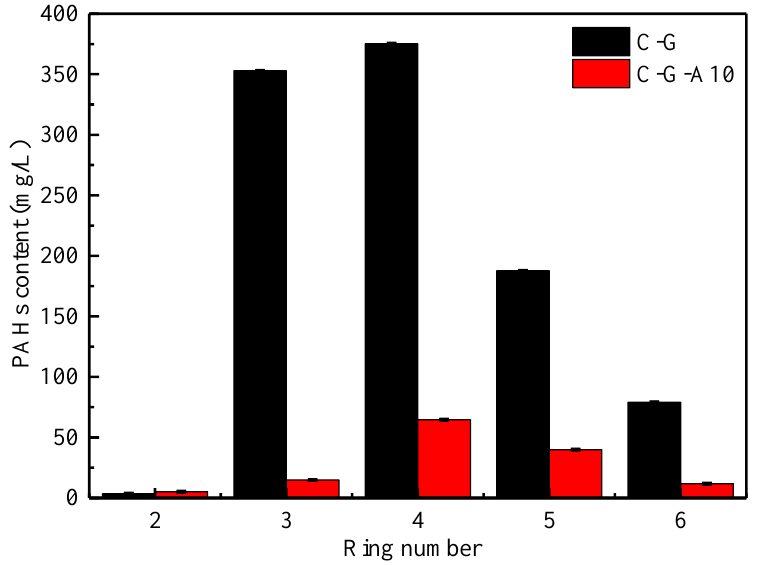
Figure 8. Content of different ring number PAHs in flue gas of coal and pitch co-carbonization (C-G: PAHs in flue gas co-carbonized by coal and original CTP; C-G-A10: PAHs in flue gas co-carbonized by coal and the catalytic air-oxidized CTP).